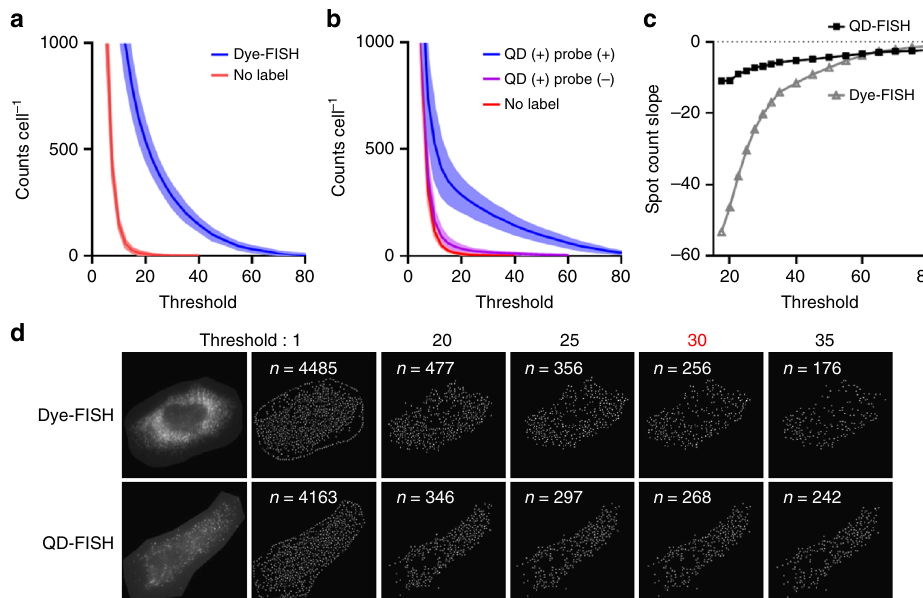
Fig. 2 Computational identi fi cation of mRNA spots. a Spot counts in individual cells using Dye-FISH (blue) or cells without labels (red) for different spot detection thresholds (described further in Methods). Shading indicates s.d. of counts between cells. N = 7. b Spot counts in individual cells using QD-FISH (blue), cells with QDs added but no probe oligonucleotides (purple), or cells without labels (red), for different detection thresholds. Shading indicates s.d. of counts between cells. N = 7. c Slopes of positive counts plotted against detection threshold. d Representative 2D images of Dye-FISH and QD-FISH are shown on the left, next to calculated images showing the locations of detected spots in white for each of the threshold values indicated above the images. The higher stability of detection for QD-FISH is evident from the similar numbers of detected spots for each of the threshold values spanning 25 – 35, compared with a wider range of detected spots for Dye-FISH. Inset numbers, n , indicate the number of detected